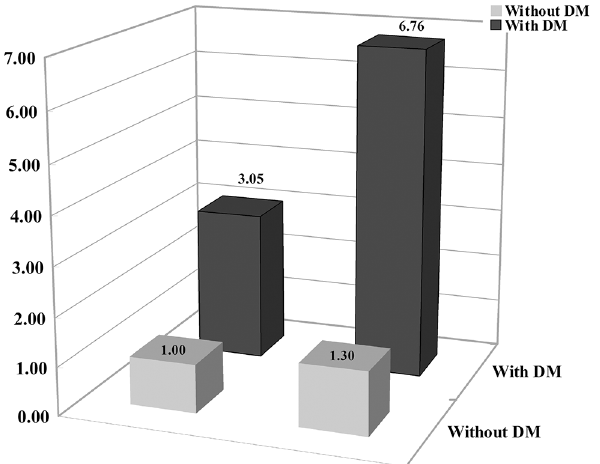
Fig 1. The effects of DROSHA rs10719T > C variant on colorectal cancer (CRC) development modulated by diabetes mellitus (DM). Y-axis represents fold changes between DROSHA genotype TT+TC and DROSHA genotype CC. Each row represents the patients with or without DM. Each column represents DROSHA genotype TT+TC and DROSHA genotype CC.